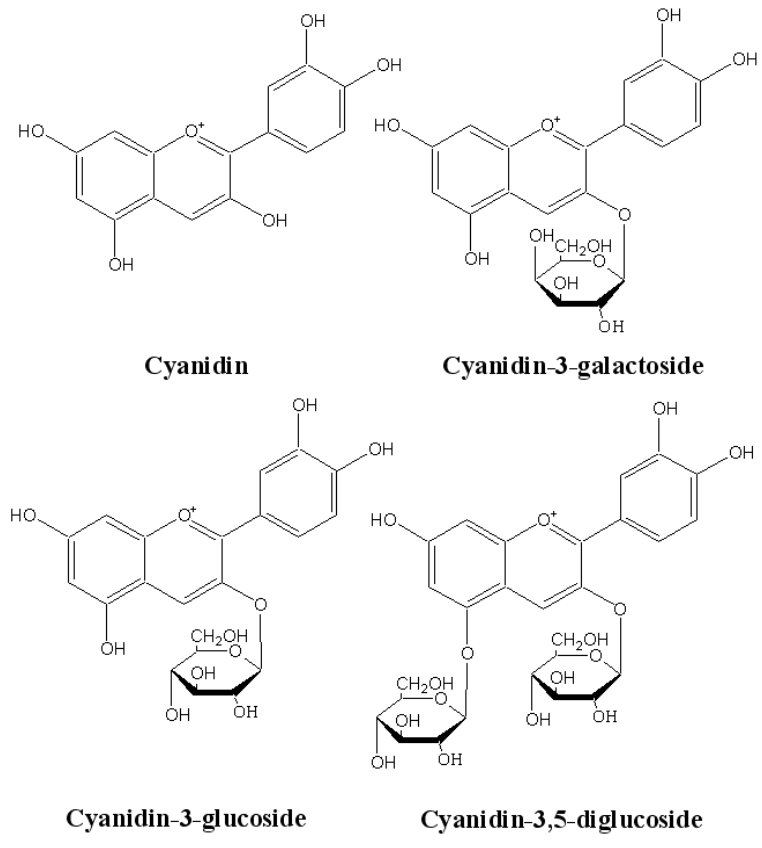
Figure 1. The structure of cyanidin and its